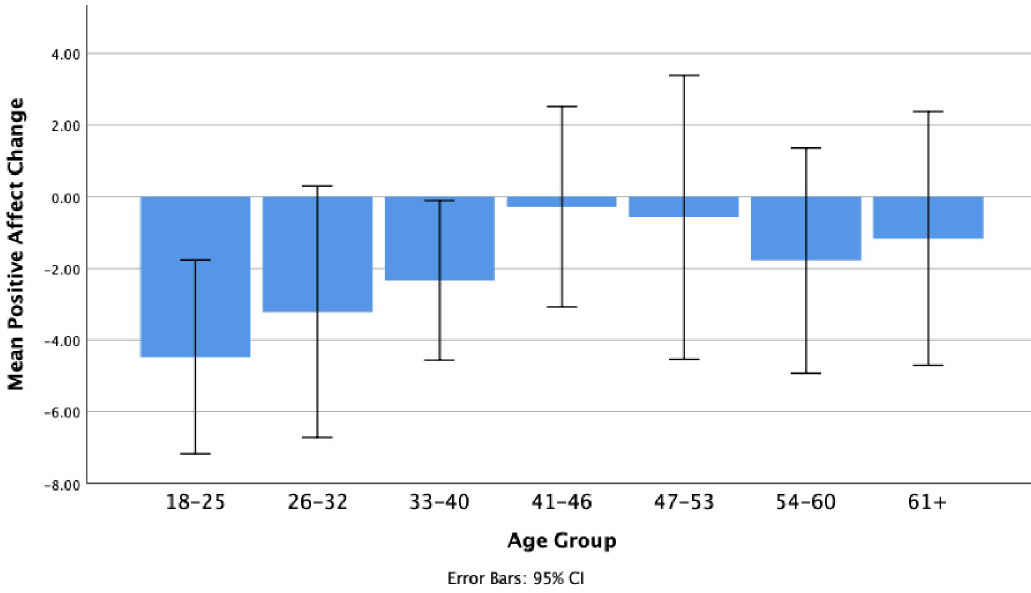
Fig 1. Change in positive affect as a function of age